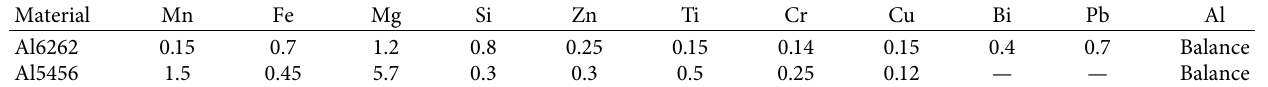
Table 1: Chemical composition Al6262 and Al5456 alloys (in wt.%).